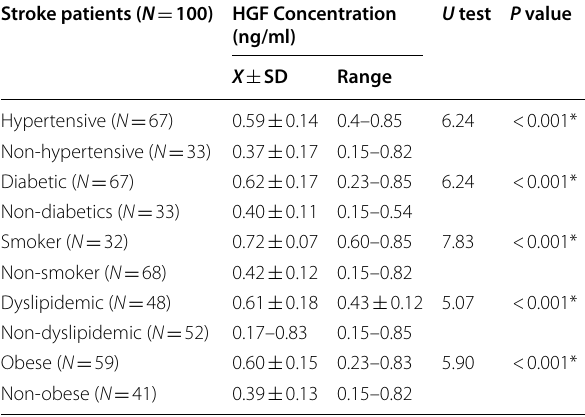
X 2 Chi‑square test, MRS Modified Rankin Scale, *highly significant